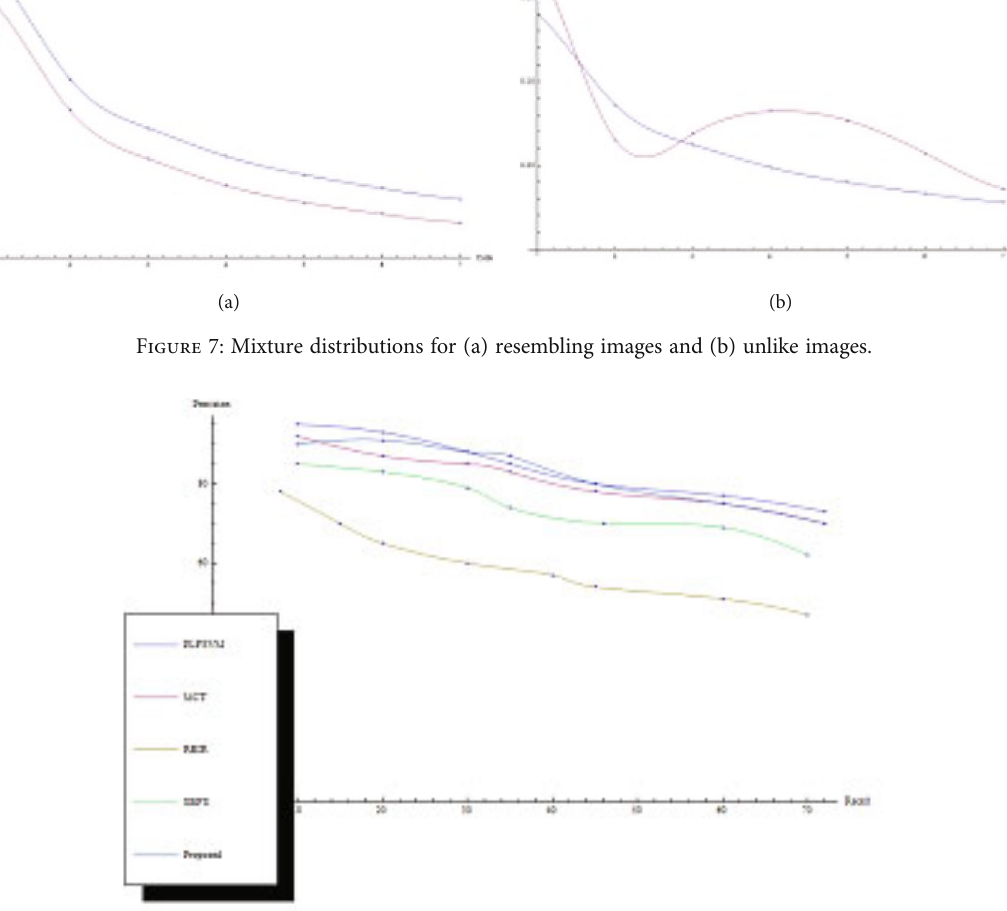
Figure 8: Precision-recall graph for certain competitive techniques in comparison with the proposed one.